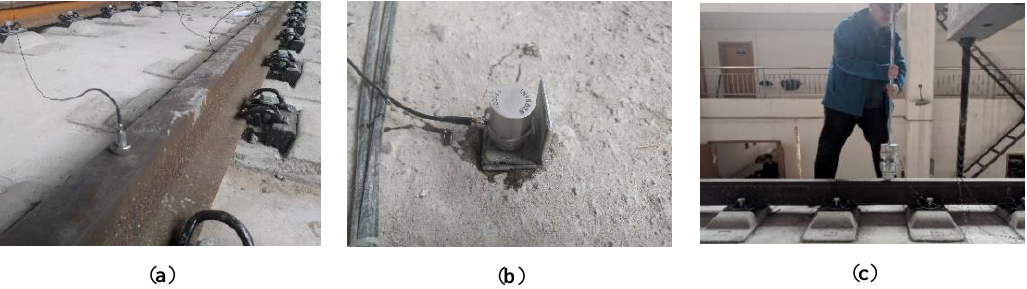
Figure 4. Sensors and hammering test. ( a ) The sensor on the rail; ( b ) The sensor on the concrete slab; ( c ) Hammering test.